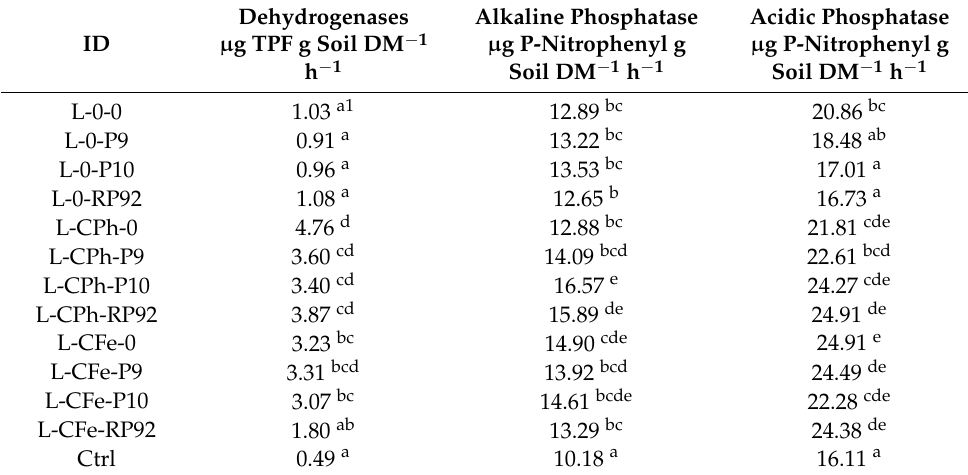
Table 2. Enzyme activity of soil as dependent on the remediation